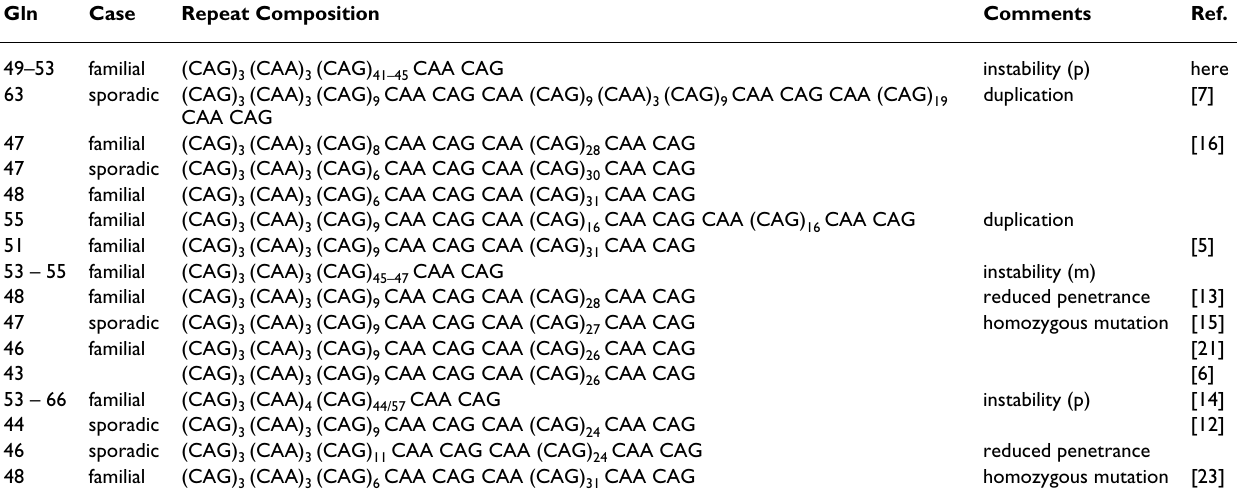
Table 1: Review of Gln Repeats and SCA17 Alleles of 16 Unrelated Cases. Duplicated elements are boxed, instability by maternal (m) or paternal (p) inheritance.